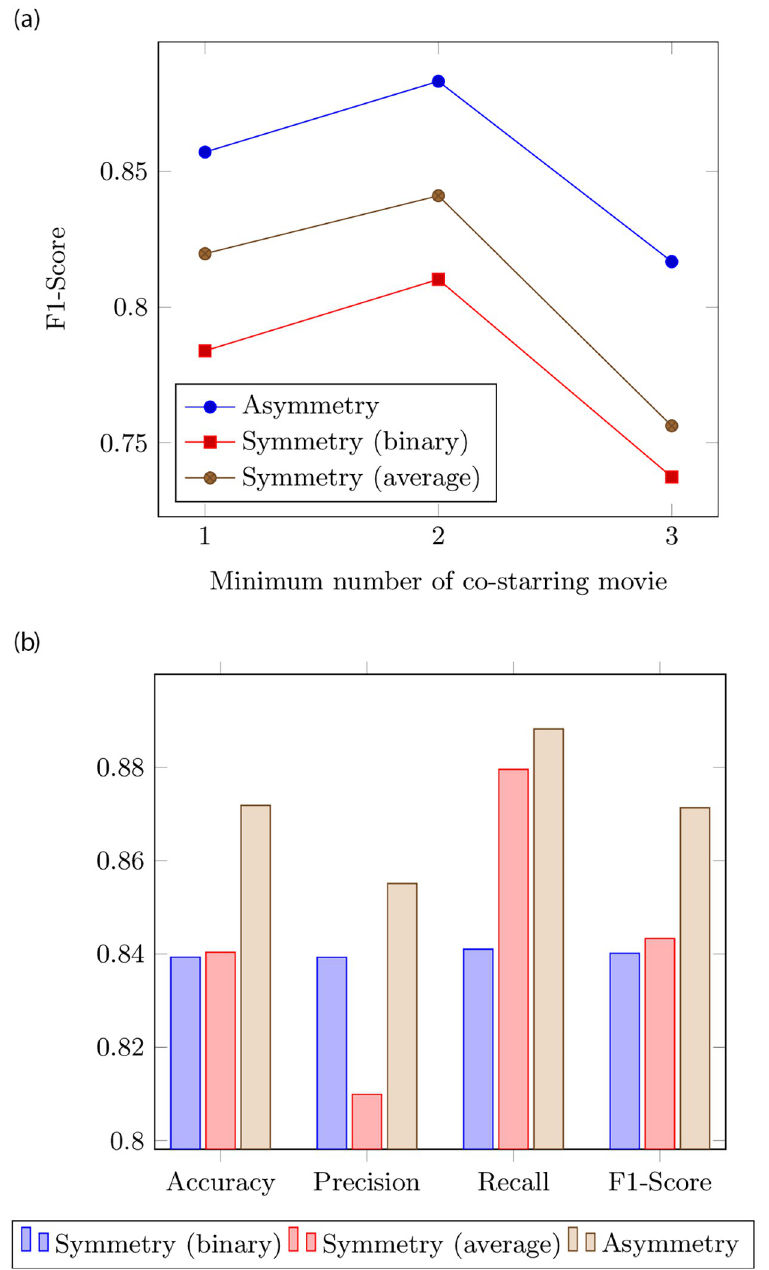
Fig 5. Result of prediction. (a) F1-score of prediction according to minimum number of movies (b) Performance comparison of symmetric and asymmetric synergy prediction.